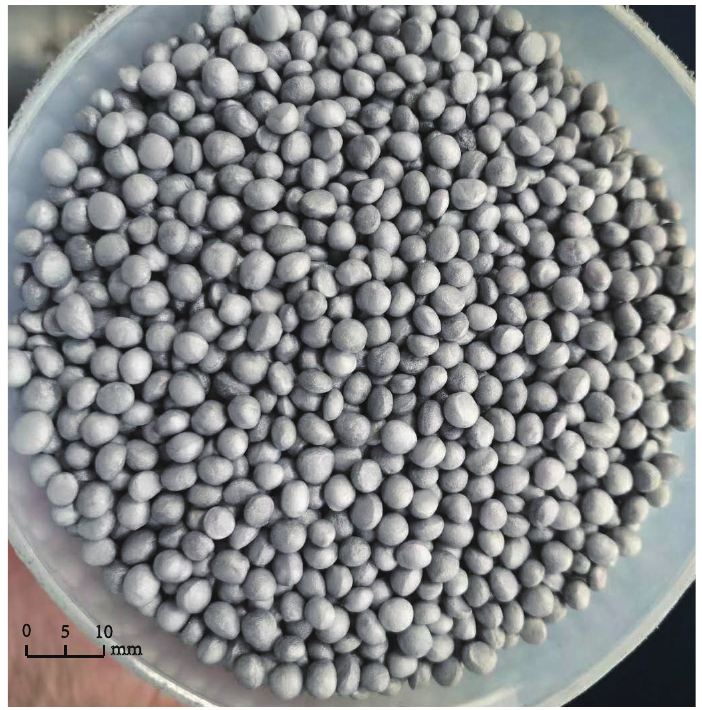
Figure 2. Appearance of graphite polystyrene